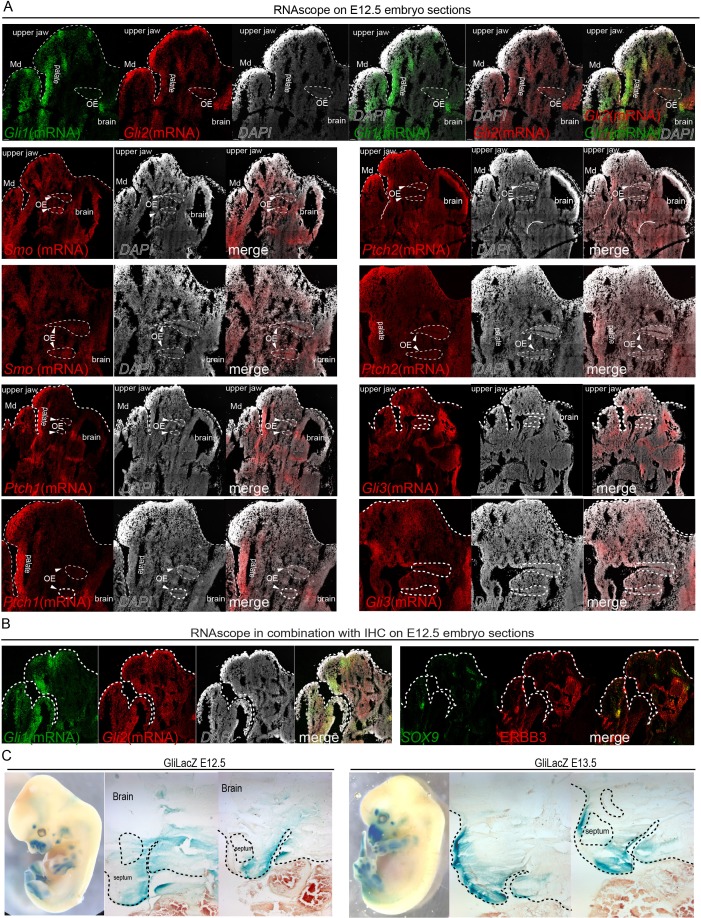
Mapping of the presence of major SHH signaling components in the E12.5 embryo.(A) Mapping of the presence of mRNA for Gli1, Gli2, Gli3, Smoothened (Smo), Patched1 (Ptch1), Patched2 (Ptch2) on the sagittal sections of embryonic E12.5 heads using RNA-Scope method. For better visualization, the major structures are outlined by dotted lines. OE-olfactory epithelium, upper jaw, Md-mandible. (B) RNA-Scope mapping of Gli1, Gli2 with subsequent immunohistological analysis of the positions of mesenchymal condensations and other relevant structures stained for SOX9 and ERBB3 on the same slides. (C) X-gal staining for revealing expression of Gli1-LacZ in E12.5 and E13.5 embryos, whole mount and on cryosections. Areas of interest are outlined by dotted lines (e.g. septum). (A–B) 8 µm thick cryosections were used and scanned with a confocal microscope (C) 25 µm thick cryosections were used and imaged with a phase contrast microscope.